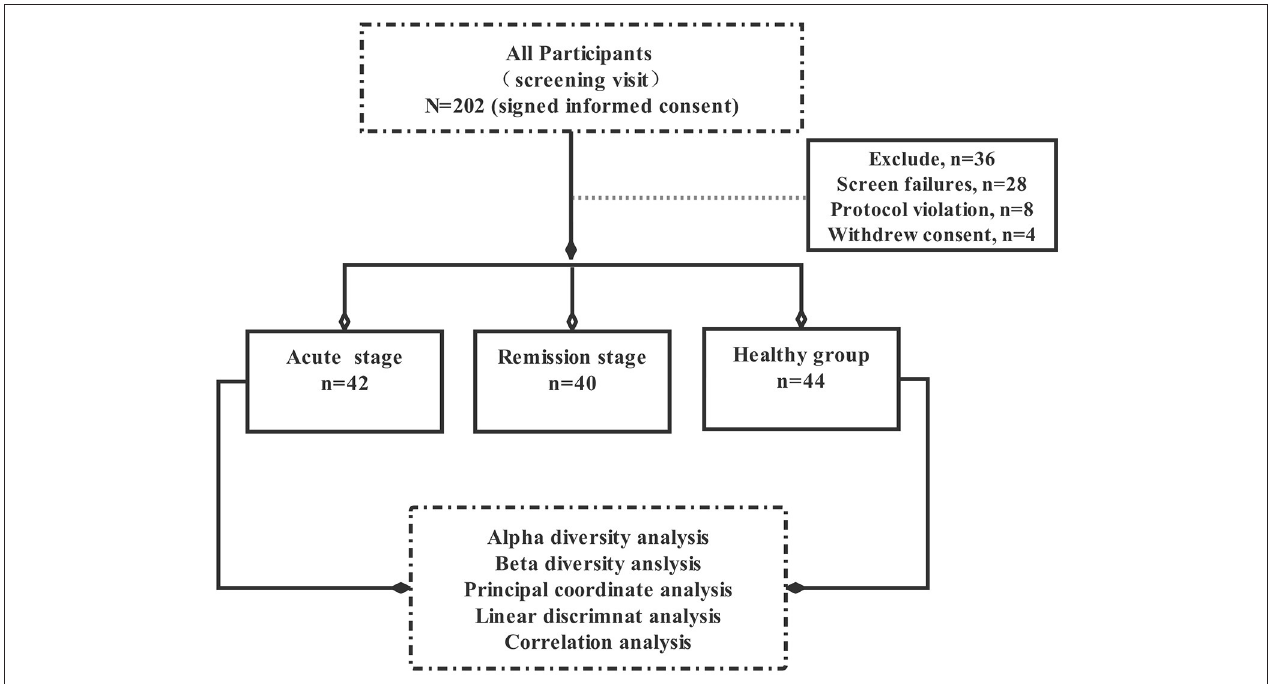
FIGURE 1 | Study selection